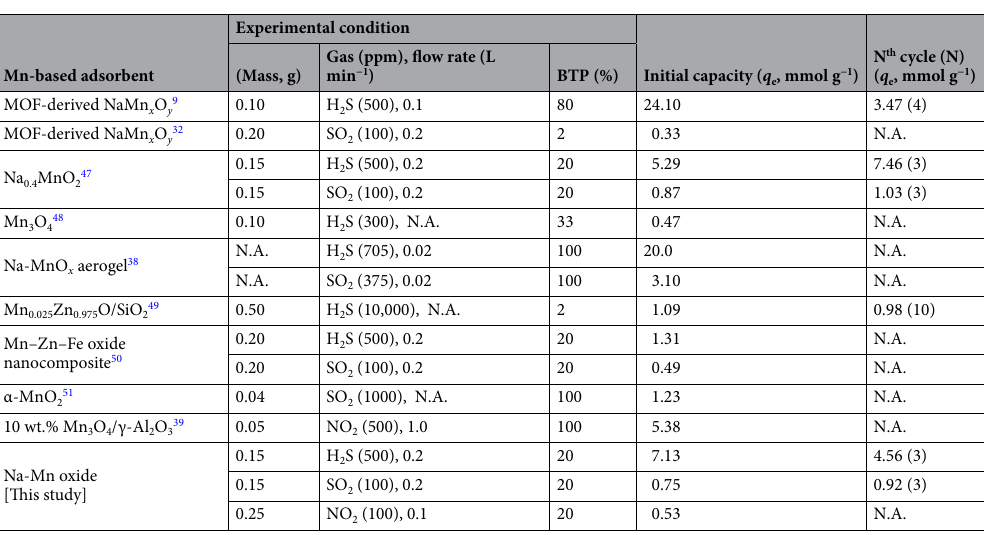
Table 1. The acidic gas adsorption capacity of Mn-based adsorbents at room temperature. N.A., Not available; BTP, Breakthrough